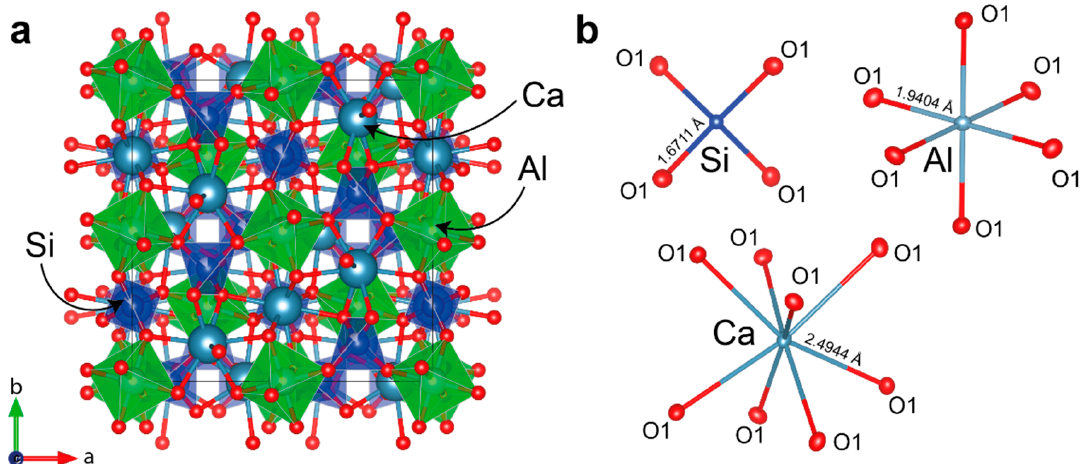
Figure 3. ( a ) Projection of the Ia3d model crystal structure of (H 4 O 4 ) 4 − -substituted grossular along the c axis; ( b ) coordinational polyhedra and bond lengths for the Ia 3 d model. Displacement ellipsoids are drawn at the 50% probability